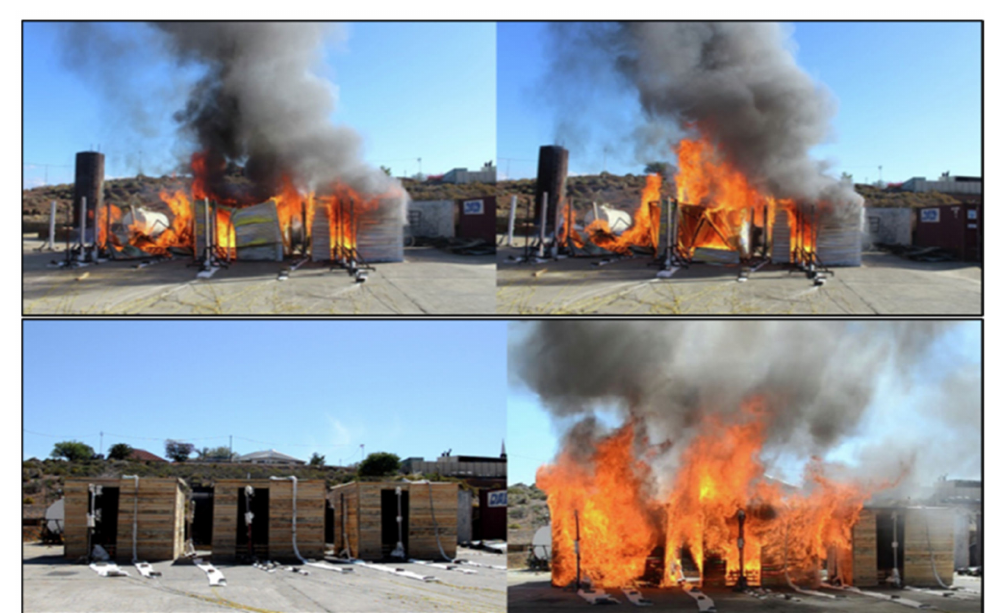
Figure 2. Fire spread between multiple full-scale informal dwellings. ( Top ) Steel-clad dwellings, ( bottom ) wooden-clad dwelling